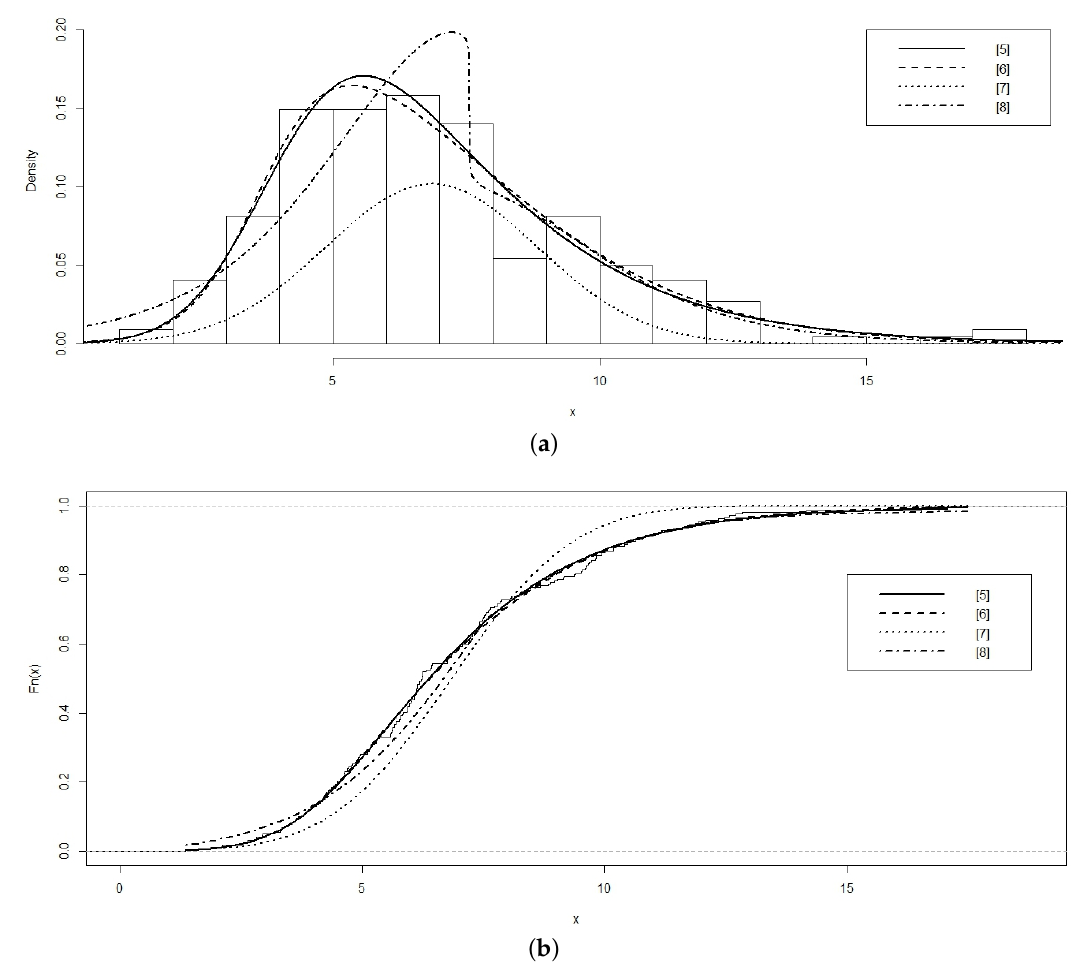
Figure B2. Health data - Fitted Nadarajah and Kotz [6] distributions. [5] Skew Logistic-Normal distribution; [6] Skew Logistic- t distribution; [7] Skew Normal-Logistic distribution; [8] Skew t -Logistic distribution. ( a ) Probability density function; ( b ) Cumulative